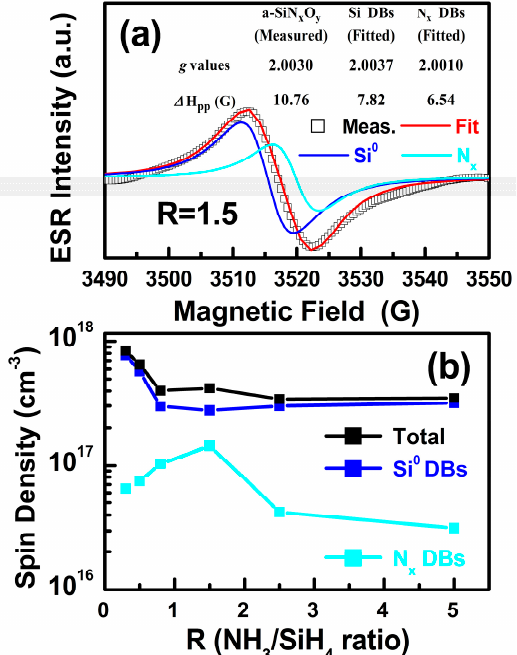
Figure 1. ( a ) The measured EPR spectra of a-SiN x O y samples (R = 1.5) and the related simulations. ( b ) The total defects, Si DBs, and N x defects spin densities vs. R.